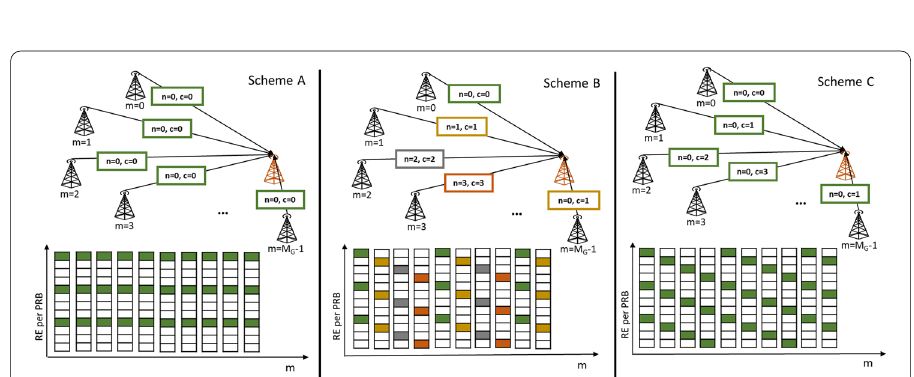
Fig. 4 Illustration of the considered remote interference scenarios for one aggressor gNB group with = 10 gNBs, in the case of N = 4 different base sequences used in the network and highlighted with M G S different colors for n = 0 (green), n = 1 (yellow), n = 2 (grey), and n = 3 (red). The RIM-RS transmissions